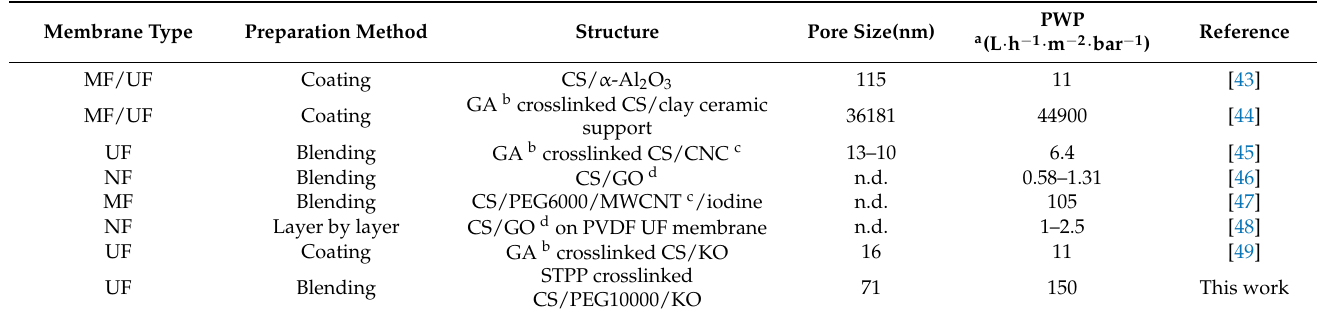
Table 5. Pure water permeability comparison of CS-containing composite membranes prepared under different